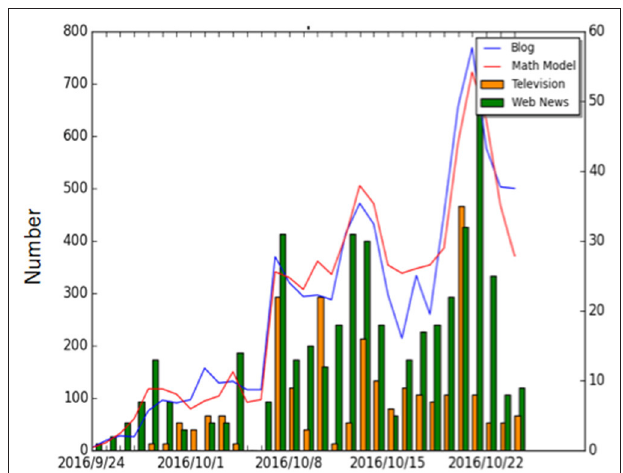
FIGURE 4 | Analysis of “Case E.” The red curve is our calculation using the model, the blue curve is the observed daily number of postings in blogs, in Japanese language, and the histograms are the daily total advertisements on TV (Orange) and the internet